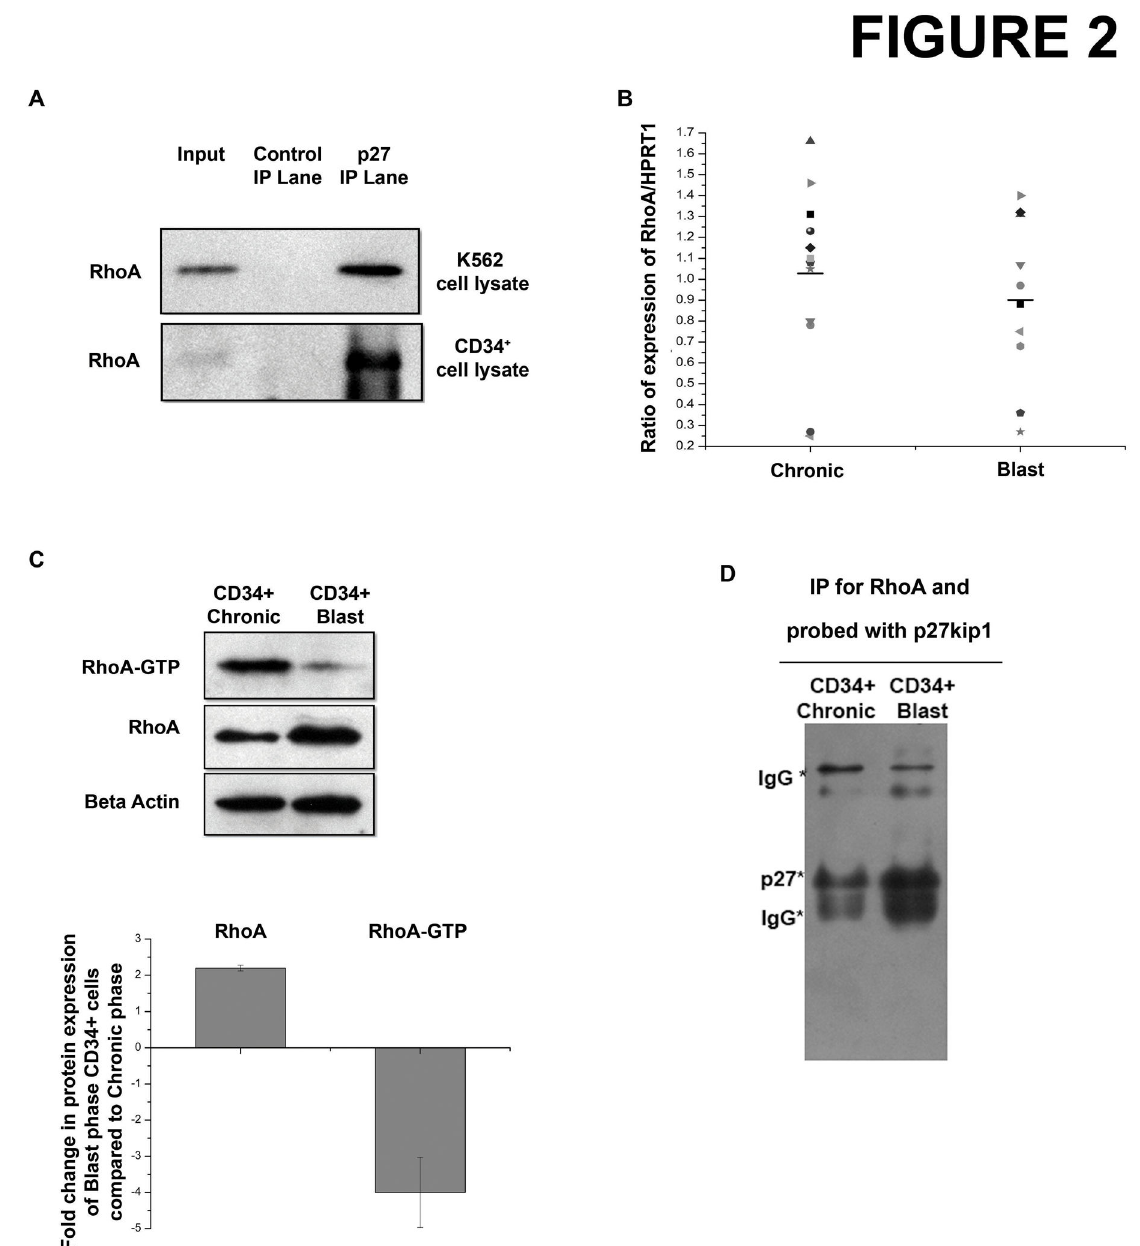
Figure 2. p27 kip1 interacts with RhoA. (A) p27 kip1 was immuno-precipitated from K562 cells and CD34 + cells of chronic phase CML followed by detection of RhoA in the resulting immuno-precipitate by western blotting. p27 kip1 and RhoA interaction was confirmed in three individual Chronic phase CML samples. (B) mRNA expression of RhoA in chronic and blast phase CD34 + stem and progenitor cells of CML was assessed by qRT-PCR. The expression was normalised against HPRT1. Horizontal bar indicates the mean of expression for the individual phase. (C) Western blot showing the expression of RhoA-GTP and total RhoA in CD34 + cells of chronic and blast phases of CML. Densitometric analysis of the blots shows the mean ± SEM of 4 individual experiments for total RhoA (p<0.001) and RhoA-GTP (p<0.01). (D) Comparative immuno-precipitation assay in which equal amounts of lysates from CD34 + cells of Chronic and Blast phase CML was used to immuno-precipitate RhoA. p27 kip1 was detected in the resulting immuno- precipitate. A total of three chronic and three blast phase CML samples were used to confirm the interaction.